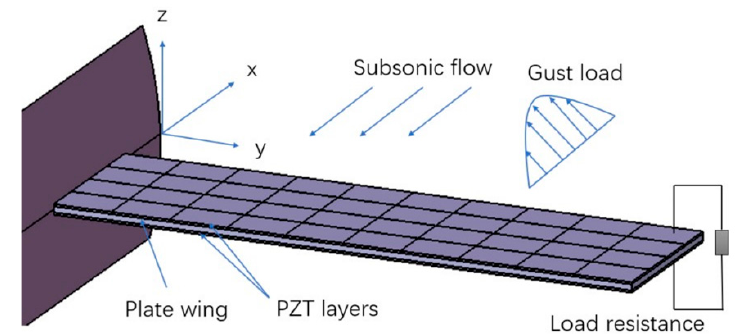
Figure 1. Plate wing covered with piezoelectric ceramic transducer (PZTs) layers.